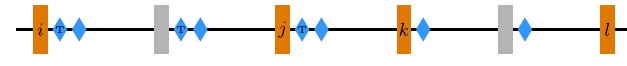
diverge.TABLE FIG. 5. The phase advances of the combination φ ij ¼ 45 °, φ cot φ m jl to